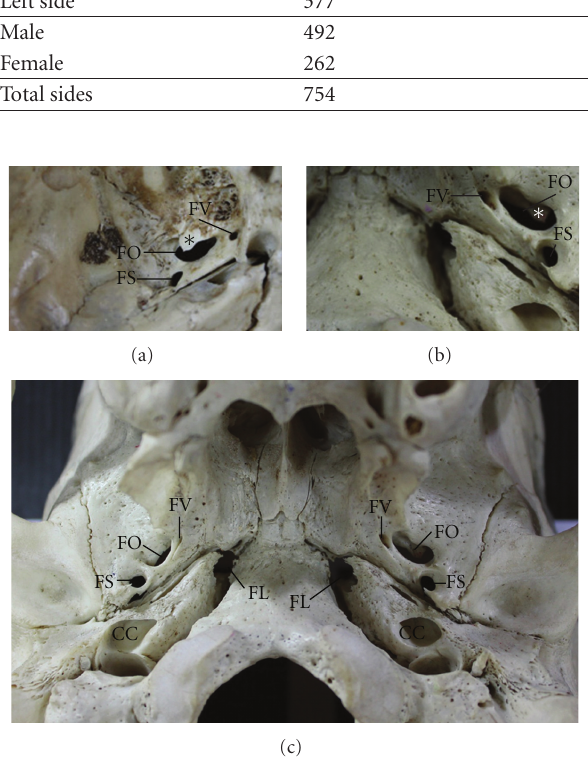
Figure 1: The FV viewed from the middle cranial fossa (a) and the extracranial view of the skull base (b). Panel (c) shows an example of the bilateral FV in the extracranial view of the skull base. The asterisks ( ∗ ) in (a) and (b) indicate a bony process which probably hinders the approach of the structures passing through the FO. CC: carotid canal; FL: foramen lacerum; FO: foramen ovale; FS: foramen spinosum; FV: foramen of